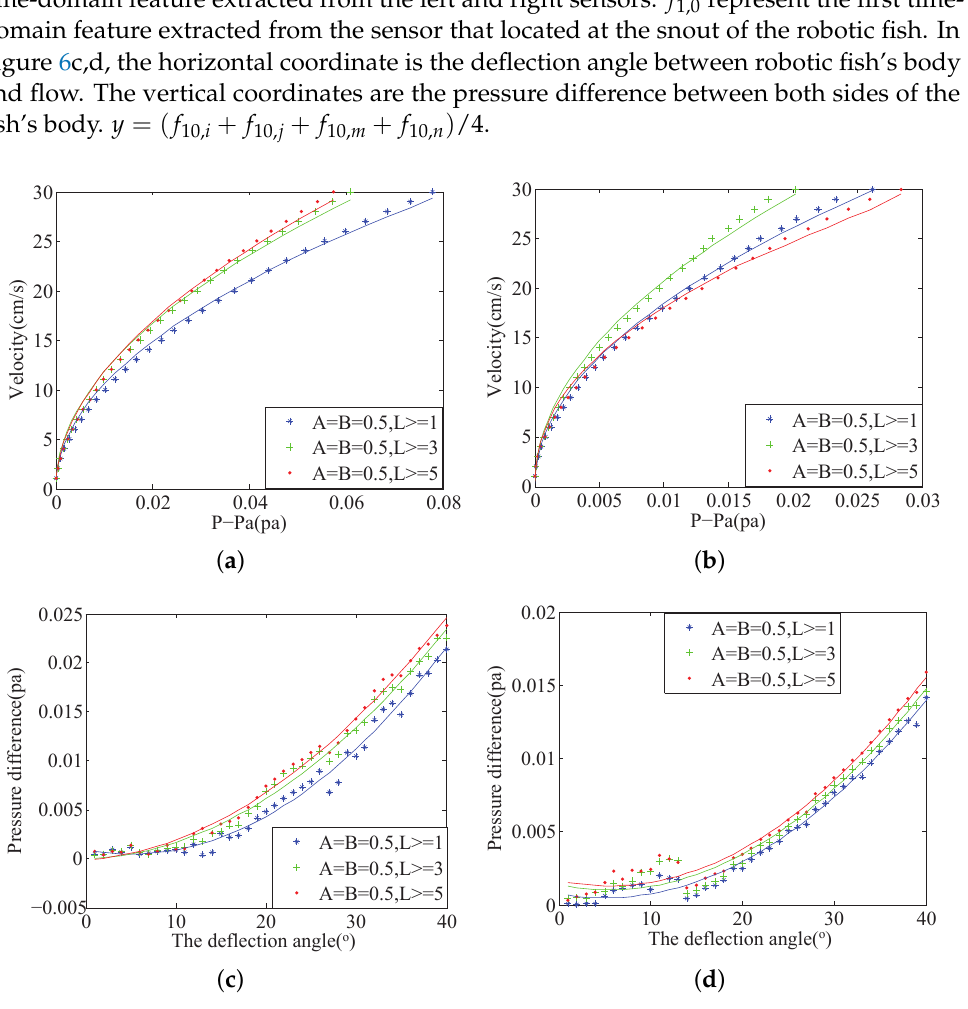
Figure 6. Model curve fitting with 4 conditions: ( a ) the UF Velocity condition, ( b ) the KVS Velocity condition, ( c ) the UF Angle condition, ( d ) the KVS Angle